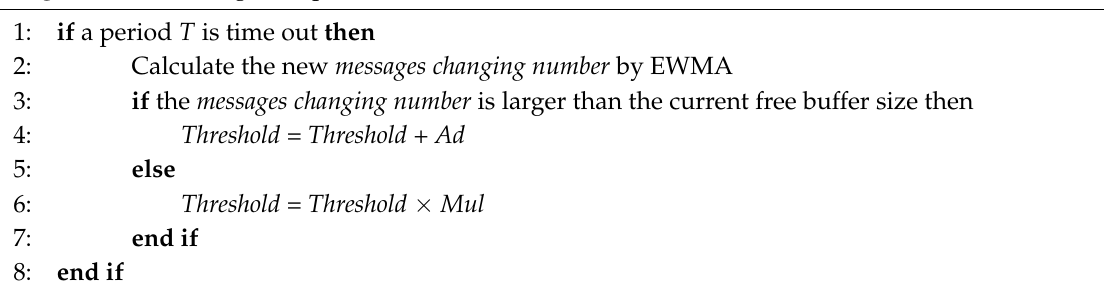
Algorithm 1. Message acceptance selection